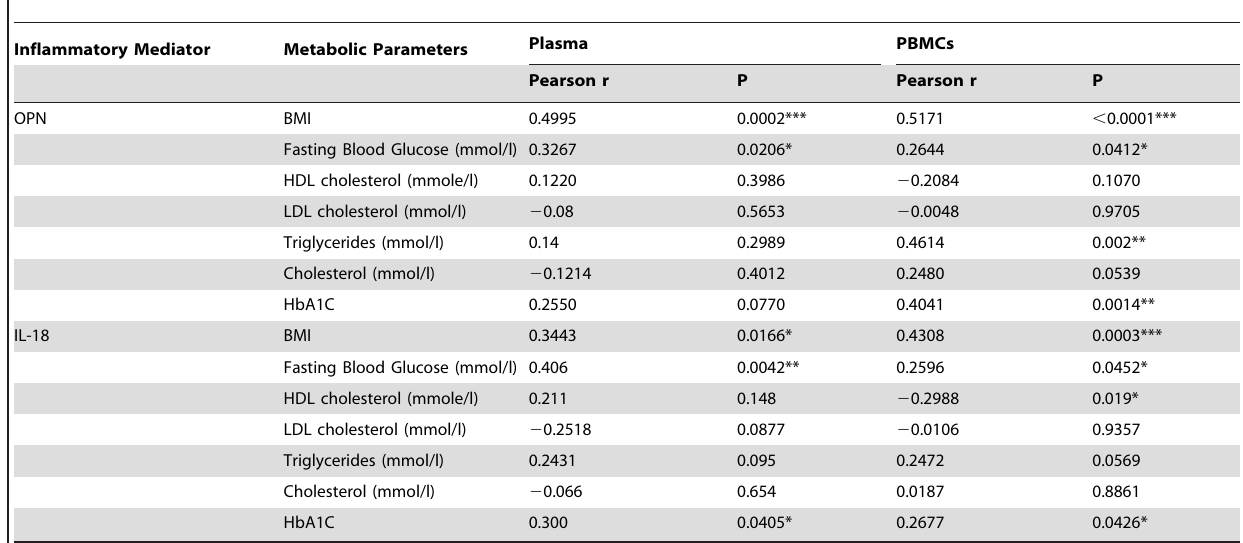
Table 2. Correlation of plasma and PBMC gene expression levels of OPN and IL-18 with metabolic markers.